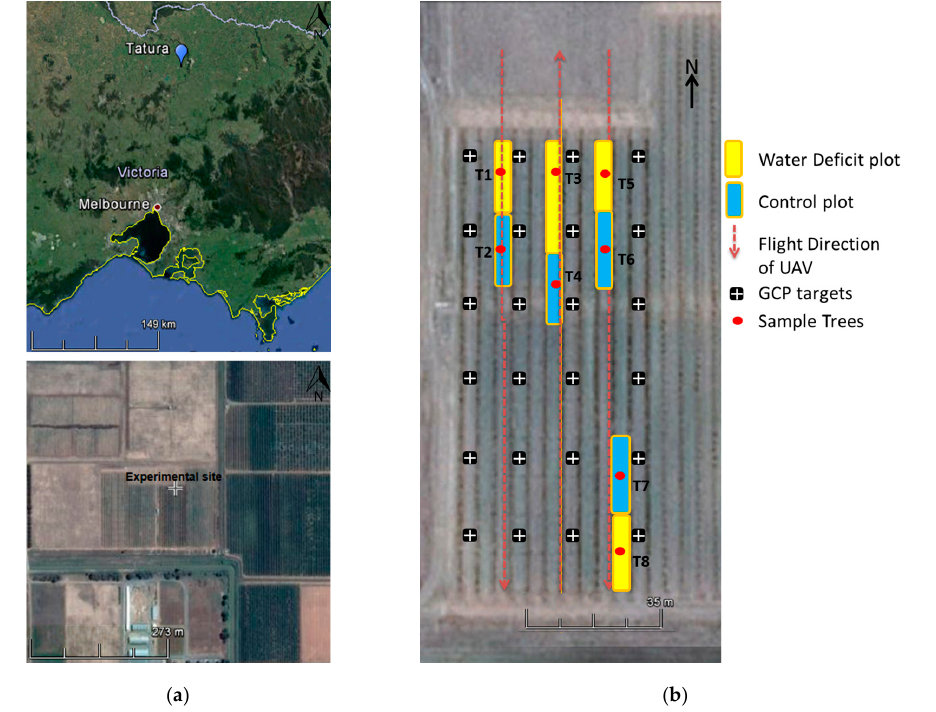
Figure 2. ( a ) Location of the study site, Stonefruit Field Laboratory orchard (Tatura, Victoria. Australia); ( b ) water deficit plots are presented in yellow, and control plots in blue. T1–T8 represents each irrigation treatment and red dots represent the biophysical sampled tree from each plot. Ground control point (GCP) targets in a black square with a white cross.